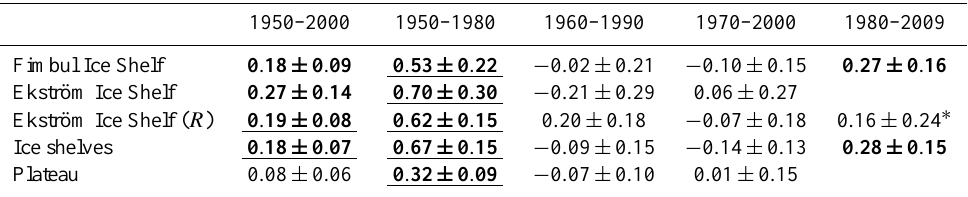
Table A2. Linear trends [‰decade − 1 ] for the stacked records of δ 18 O. Significant trends according to F test on the 95% (bold and underlined) and 90% confidence level (bold) are highlighted. The standard deviation of the slope is also given.